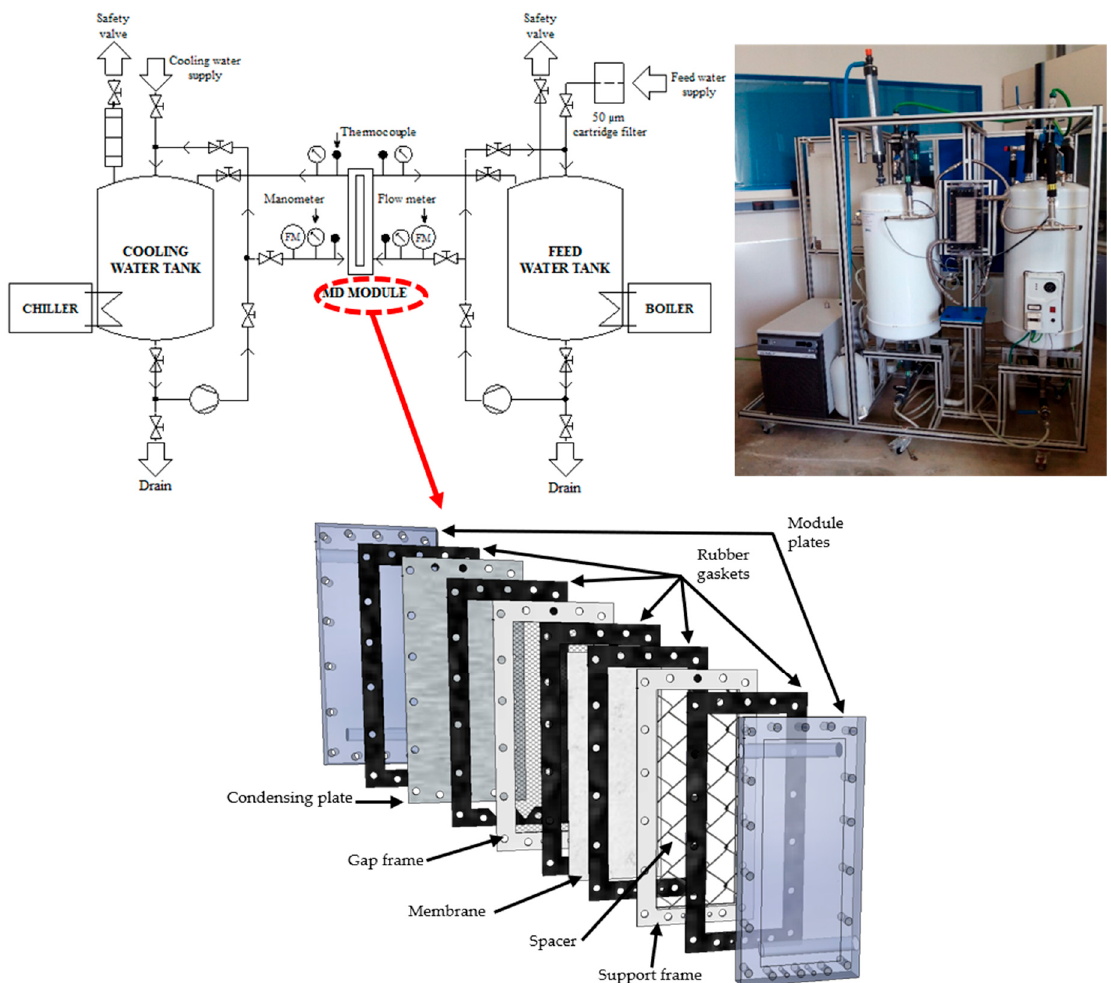
Figure 2. Schematic and photography of the MD pilot system, as well as details of WGMD / AGMD module used in this work.